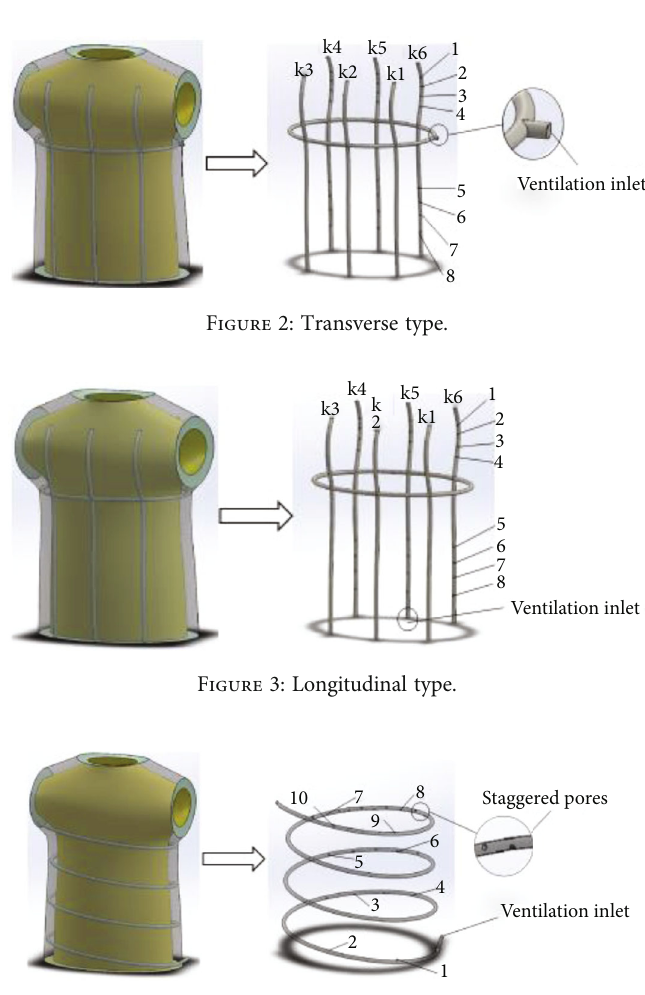
Figure 4: Spiral type.